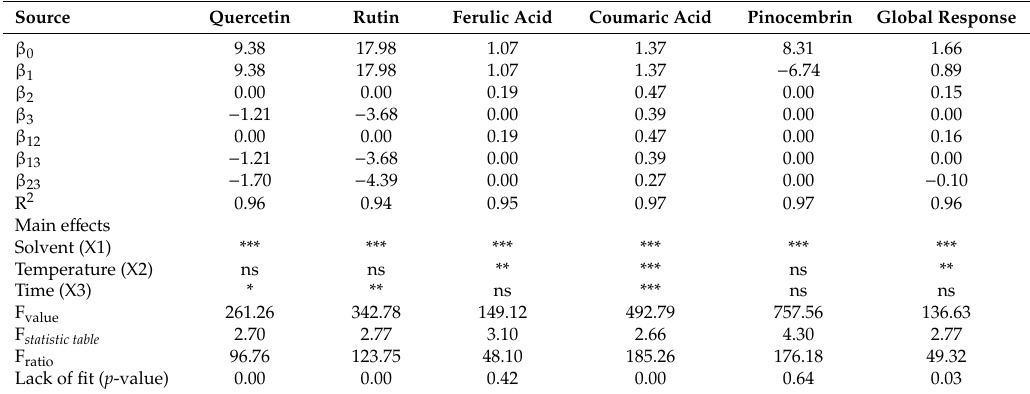
Table 2. Regression coe ffi cients of the models and analysis of variance (ANOVA) for the e ff ect of solvent type (X1), temperature (X2) and time (X3) on phenolic compounds profile.